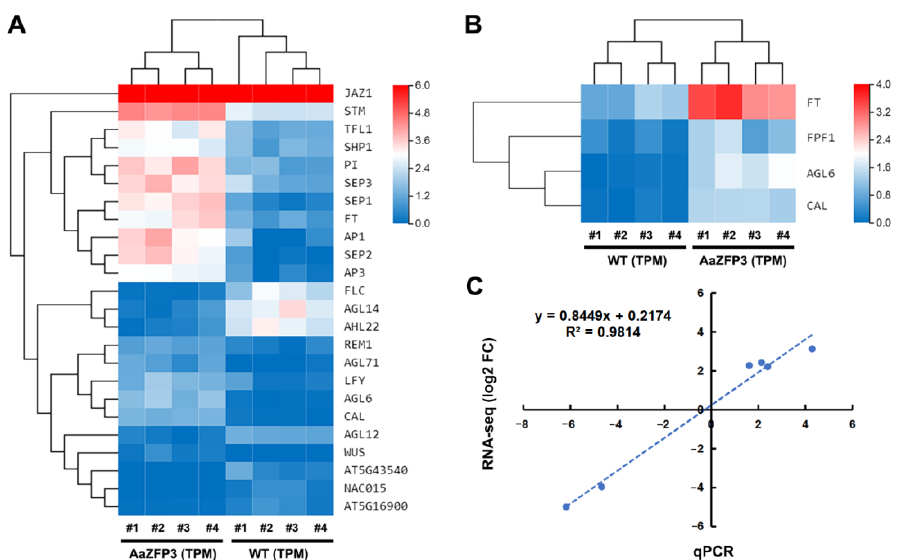
Figure 6. The RNA-seq expression levels of differentially expressed genes (DEGs) categorized in the ( A ) “flower development” and ( B ) “positive regulation of flower development” GO terms in WT and transgenic Arabidopsis plants. Red, up-regulated genes; green, down-regulated genes. ( C ) Correlation analysis between the qPCR and RNA-seq data. Detailed information on the gene names is provided in Supplementary Table S1.